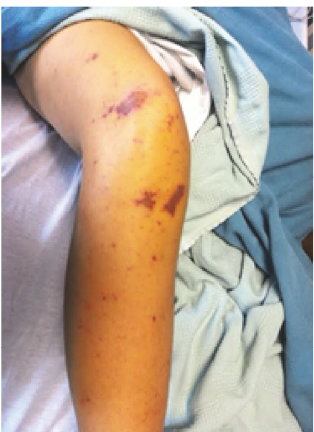
Figure 1: Right lower extremity with purpura, photo cred M. Hoffman 2015.